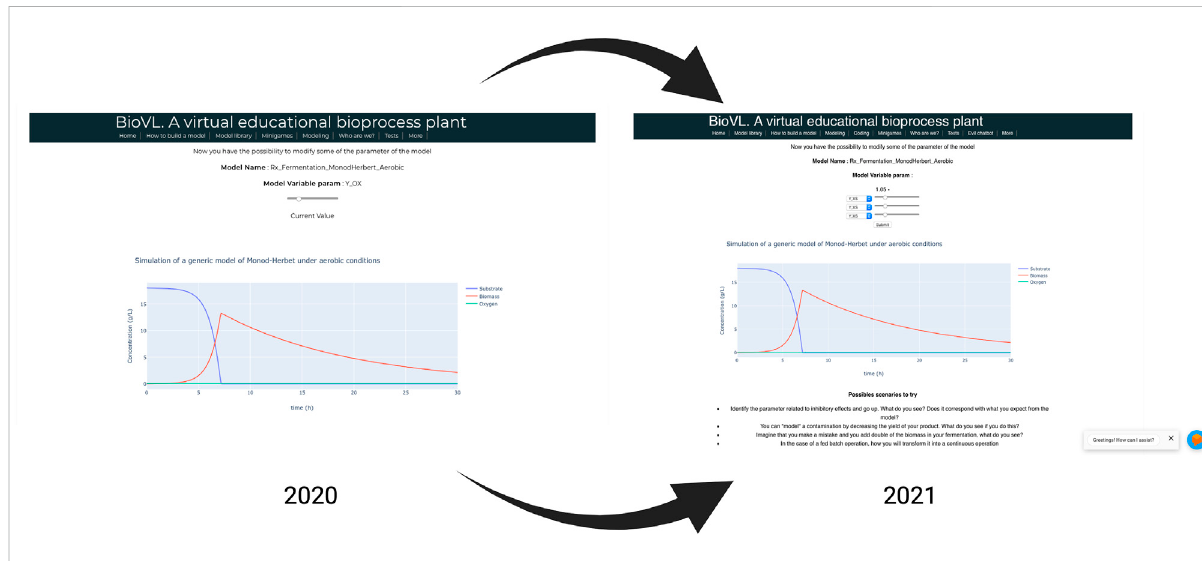
FIGURE 9 Example of a modi fi cation done to the software based on the users input.